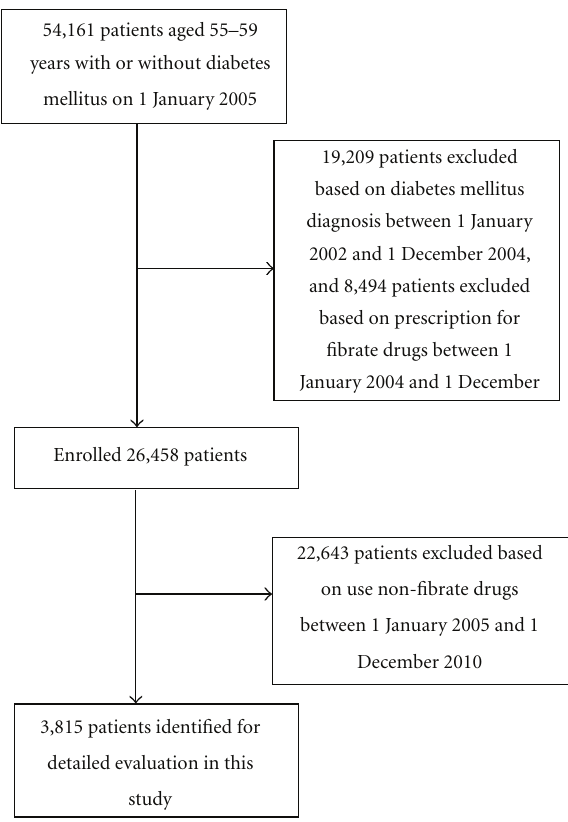
Figure 1: Flowchart of the selection of patients for